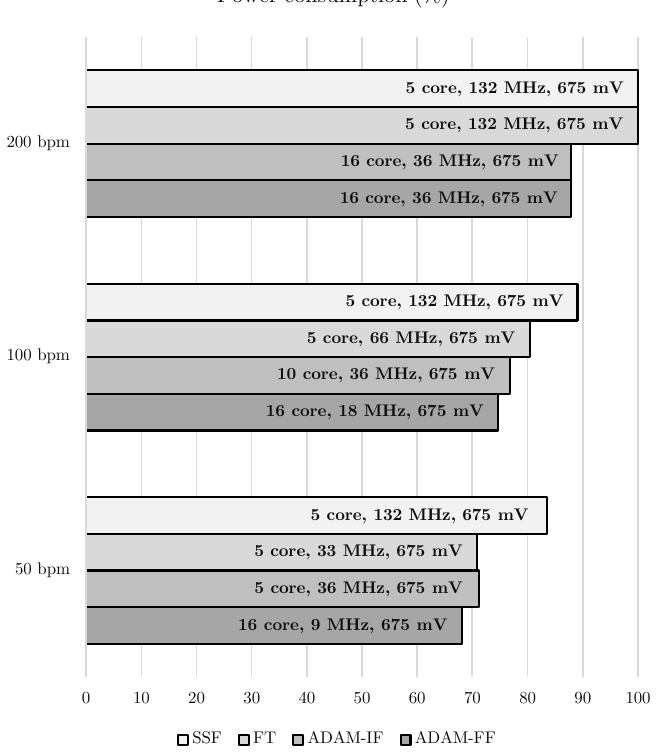
Figure 14. Comparison of power consumption considering different adaptation policies (with or without ADAM) and different